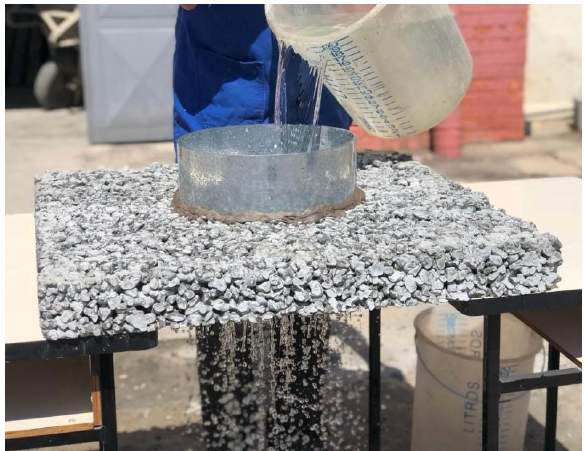
Figure 3. Permeability coefficient test.